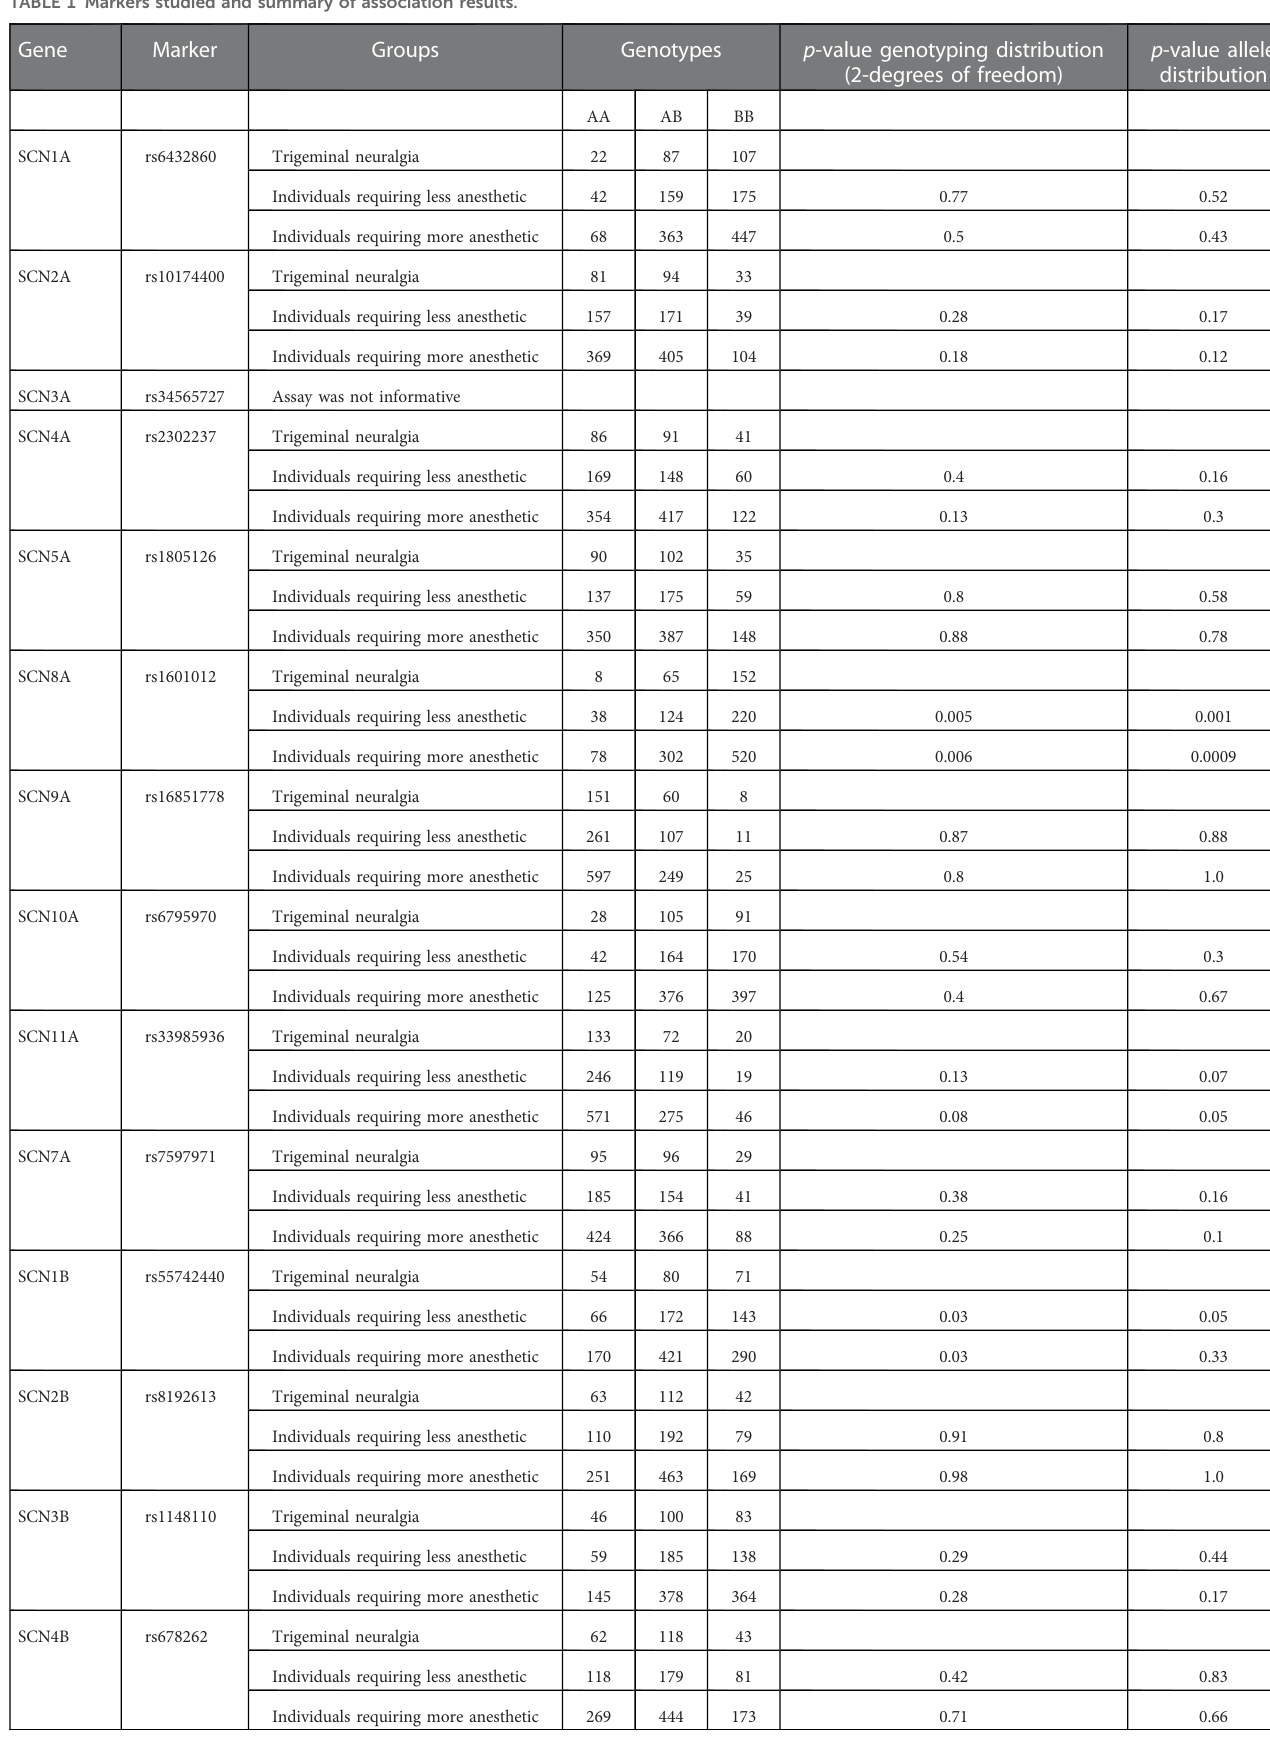
TABLE 1 Markers studied and summary of association